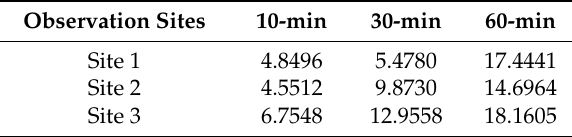
Table 14. Comparison results of three observation sites with different time